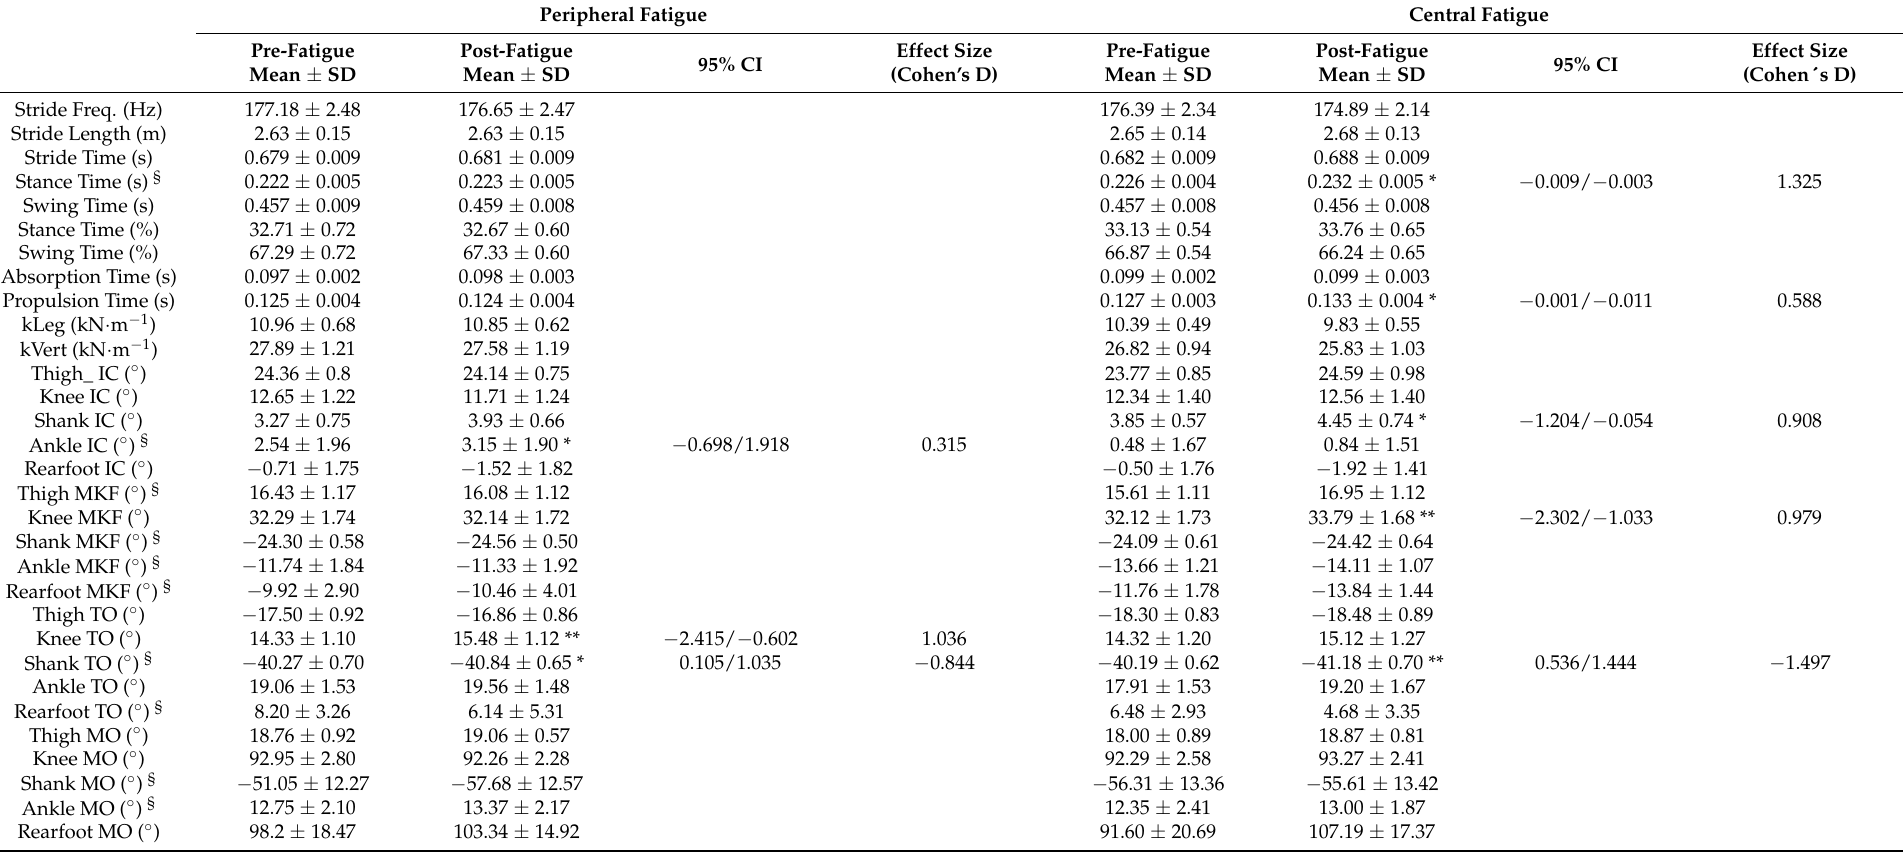
Table 2. Kinematics modification pre vs. post peripheral and central